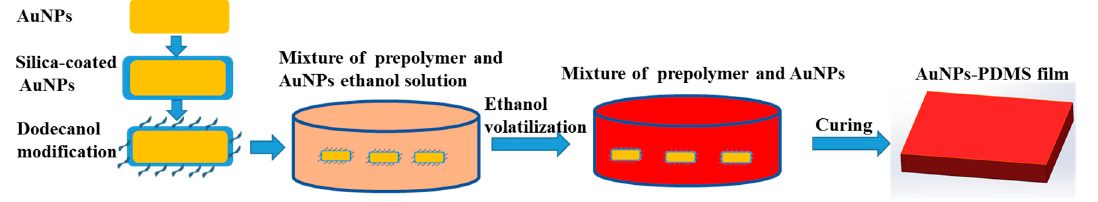
Figure 1. Schematic diagram of the AuNPs-PDMS preparation.